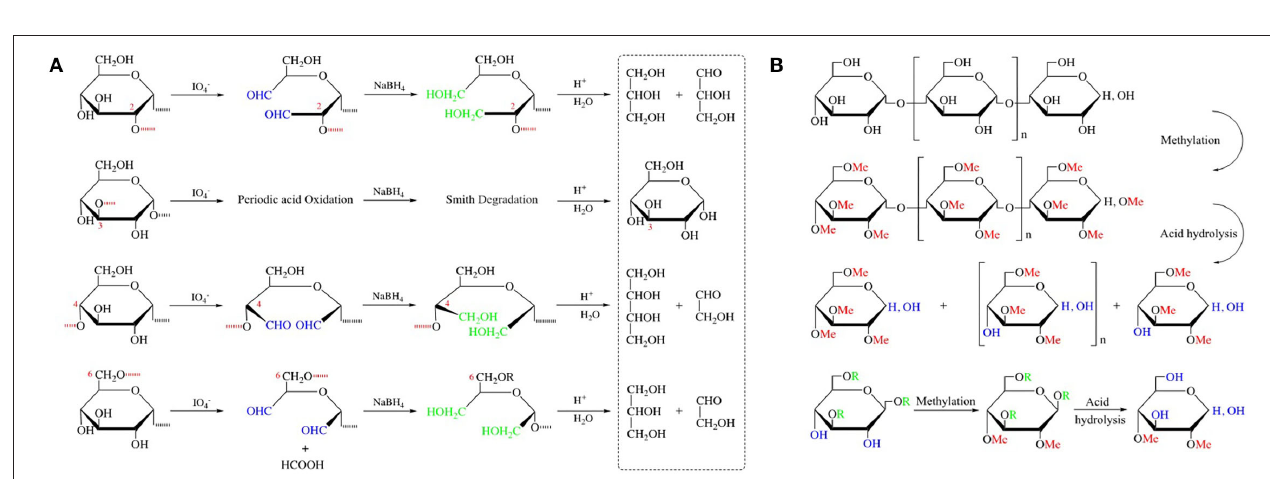
FIGURE 3 | The general process of determining the composition of monosaccharides. (A) Monosaccharide composition of Angelica sinensis polysaccharide by HPLC-UVD; (B) Monosaccharide composition of polysaccharide from the fibrous roots and tuber of Bletilla striata by IC; (C) Monosaccharide composition of polysaccharide from Dendrobium devonianum by GC-MS.